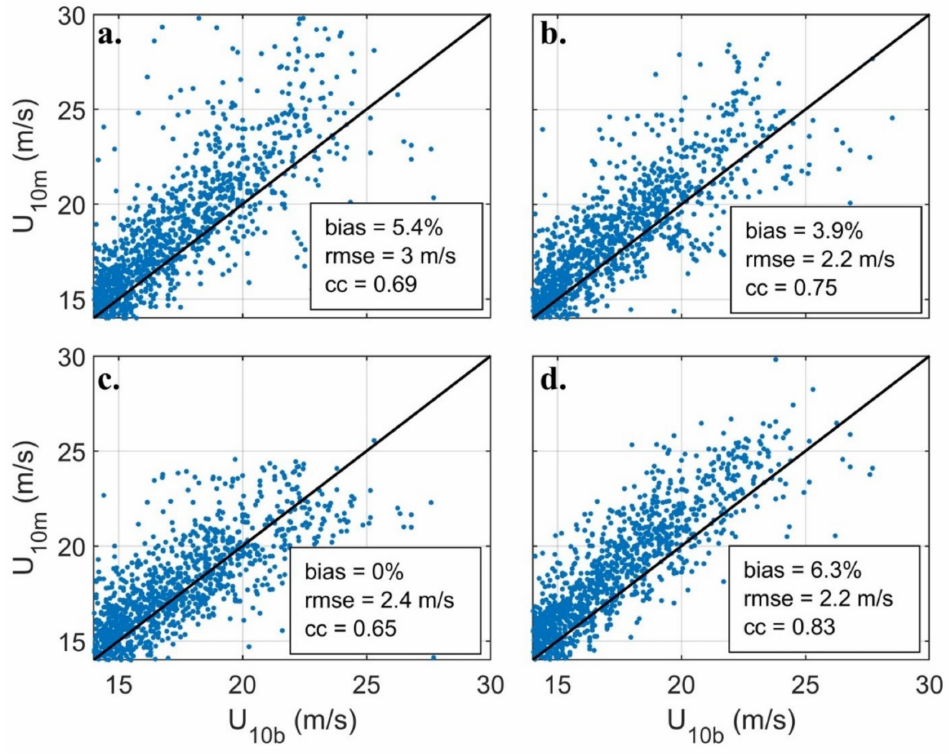
Figure 3. Buoy (U 10b )-model (U 10m ) wind comparison plots for ( a ) NCEP, ( b ) IFREMER, ( c ) ECMWF and ( d ) WIS wave models for all six hurricanes. Error statistics for each model is provided in each